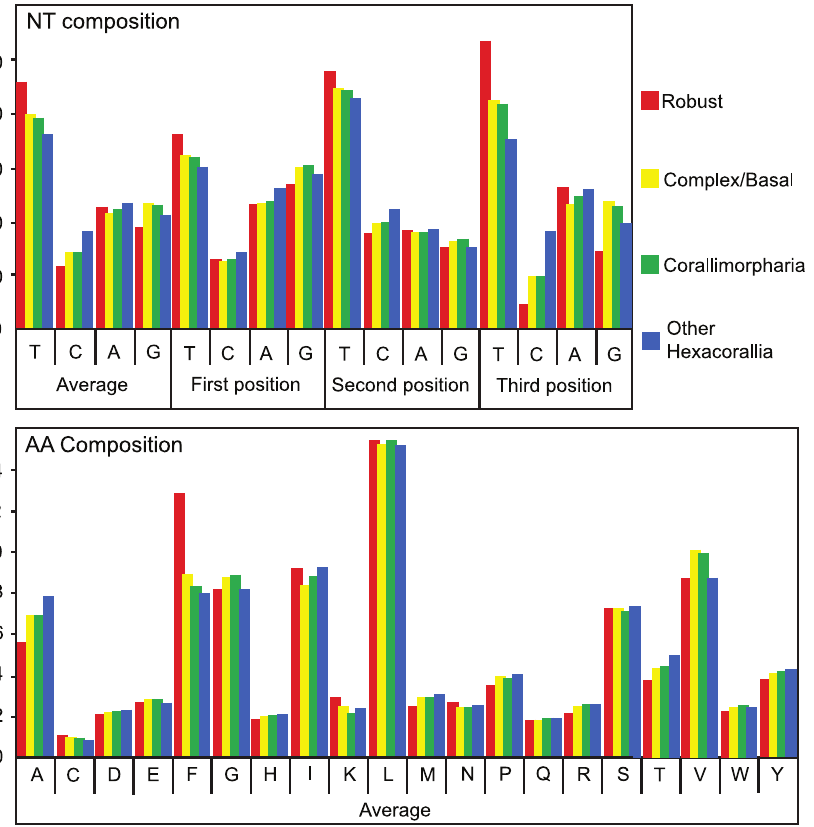
Figure 2. Nucleotide (upper) and amino acid (lower) content of the protein coding genes in the mitochondrial genomes of hexacorallians. The data shown are averages across the ‘‘Robust’’ corals (n=14), basal and ‘‘Complex’’ corals (n=17), corallimorpharians (n=12) and other hexacorallians (n=4).